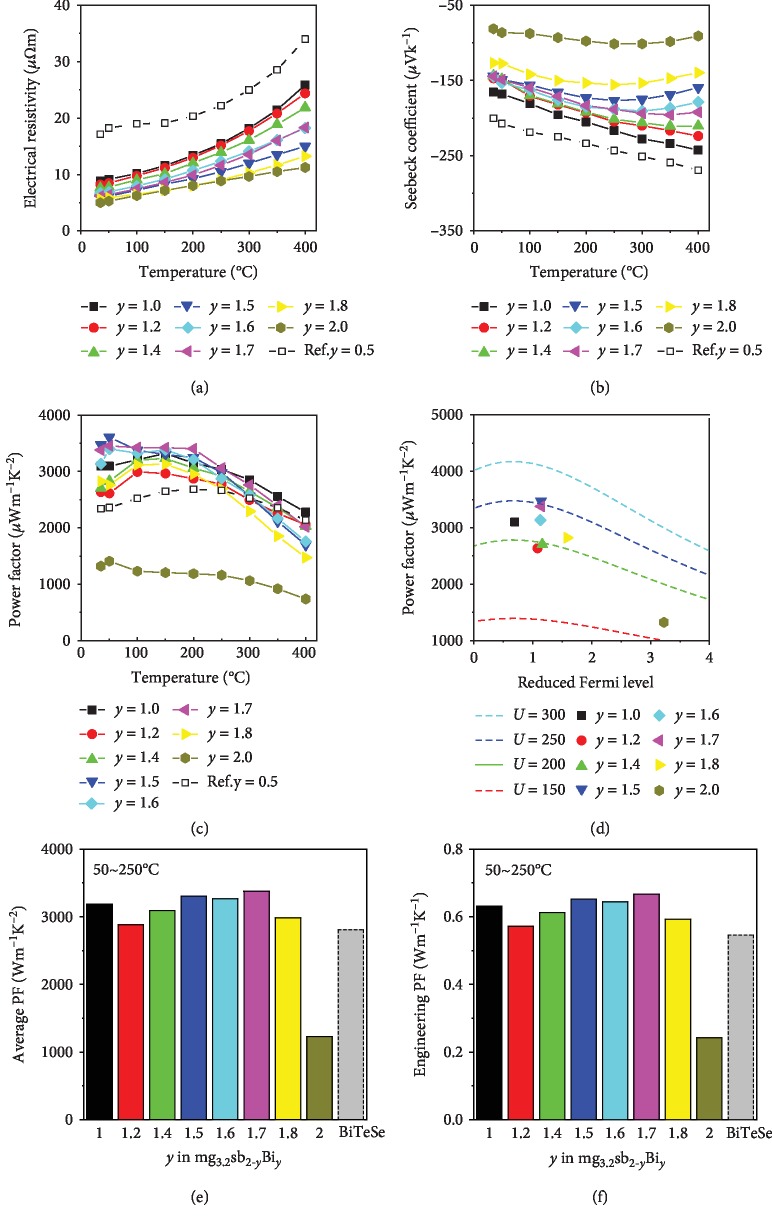
Temperature dependence of (a) electrical resistivity, (b) Seebeck coefficient, and (c) power factor of Mg3+δSb2-yBiy (y = 1.0, 1.2, 1.4, 1.5, 1.6, 1.7, 1.8, and 2.0), previous y = 0.5 as reference [4]. (d) Power factor as a function of reduced Fermi level at room temperature in condition of different weighted mobility. (e) Average power factor and (f) engineering power factor in the temperature range of 50-250°C, with Bi2Te2.3Se0.7 as a reference [41].